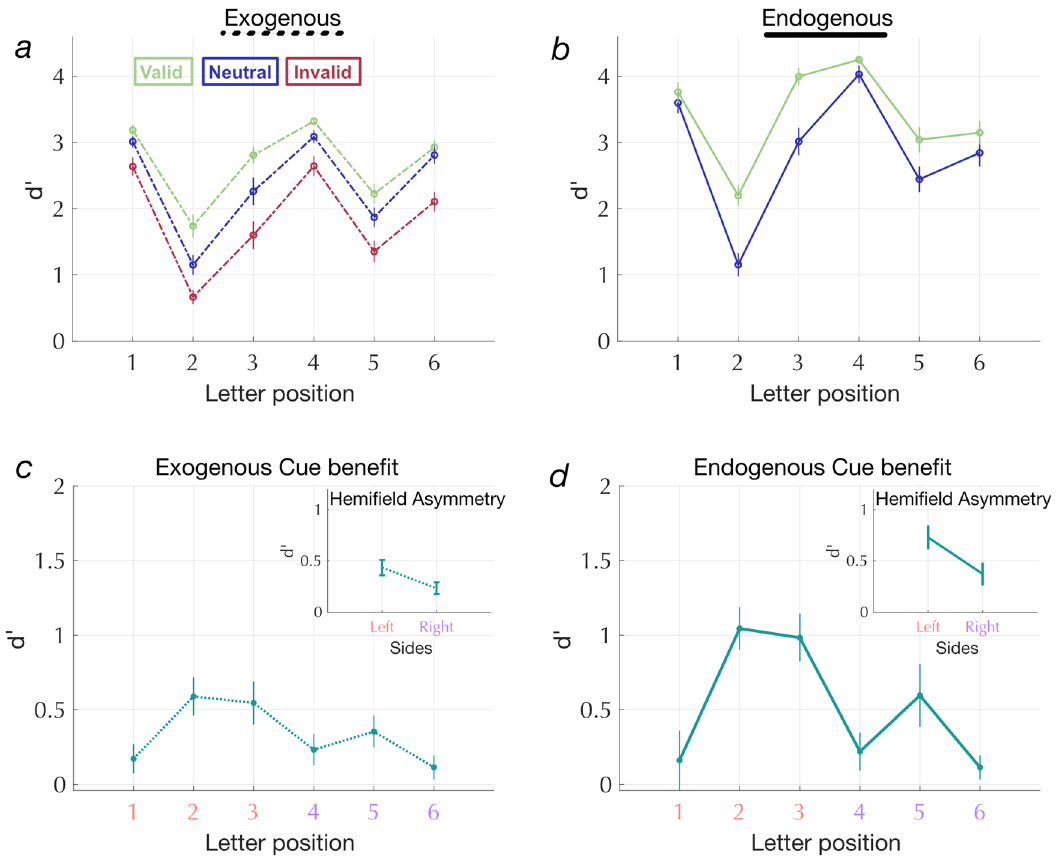
Figure 4. ( a , b ) Serial position functions are W-shaped for both cue types. ( c , d ) Cue-benefit functions for both cue types. Both exogenous and endogenous cue benefits show M-shaped profiles with larger cueing effects at crowded letter